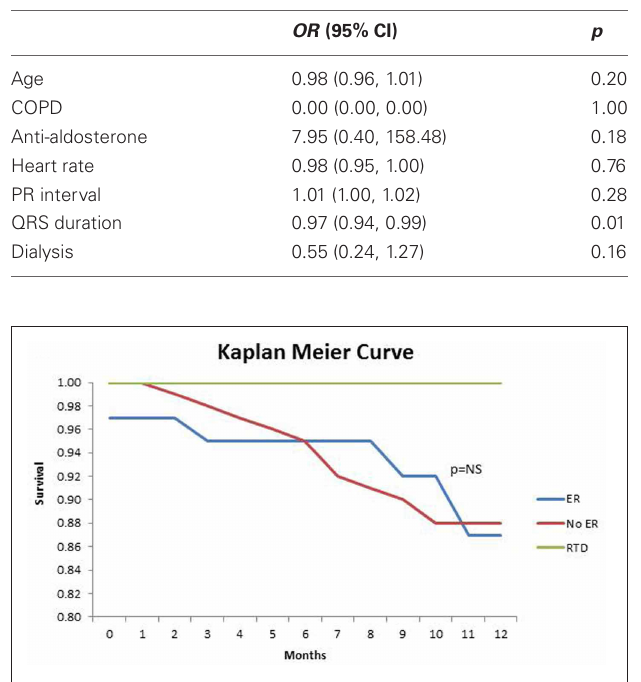
FIGURE 2 | Kaplan Meier Curve comparing 1-year survival in CKD patients with ER, without ER, and the renal transplant donors